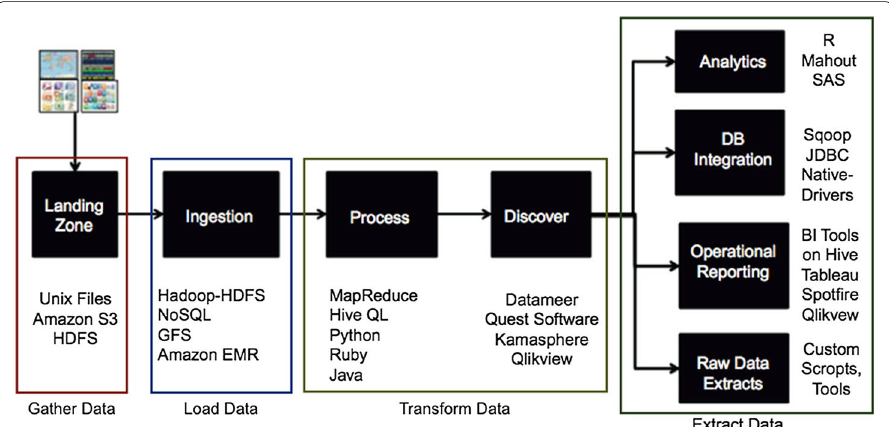
Fig. 2 Big data technology stack Source: Krishnan ([40], p. 41) and Sheikh ([41], p.